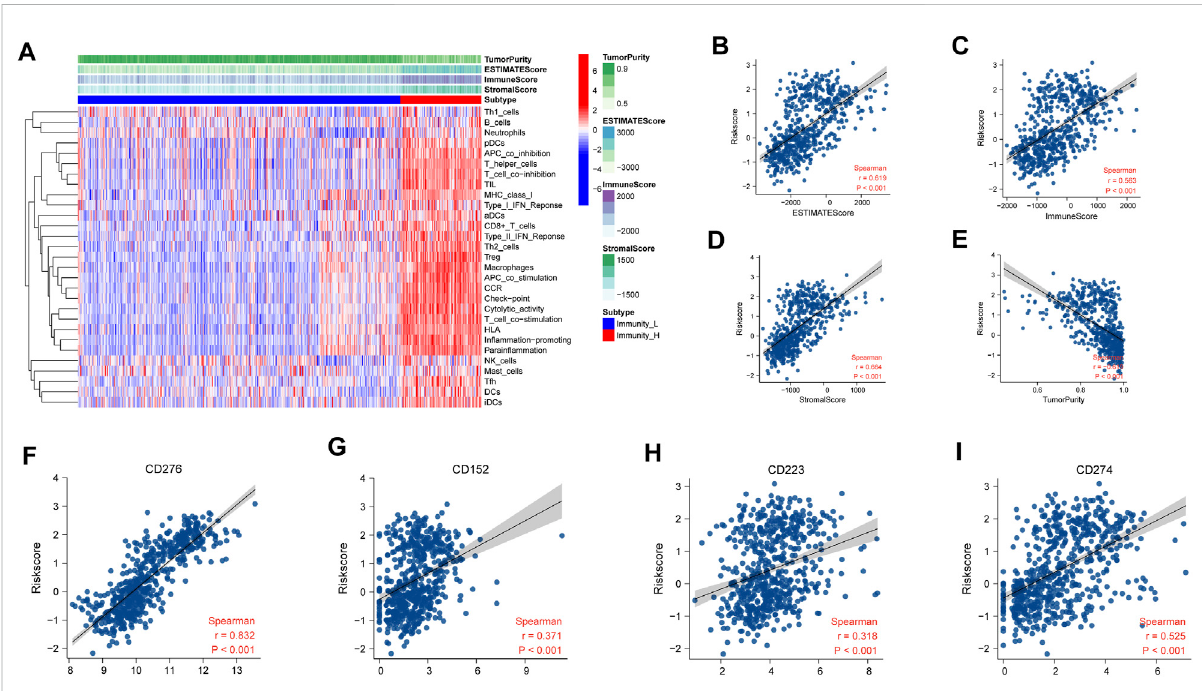
FIGURE 8 Assessment of immune in fi ltration in TCGA. (A) Heatmap of ssGSEA scores of immune cells and functions. (B – E) Relationship of risk score betweenESTIMATEscore(r=0.619, p < 0.001),immunescore(r=0.563, p < 0.001),stromalscore(r=0.664, p < 0.001),andtumorpurity(r=-0.679, p < 0.001). (F – I) Relationshipofriskscorebetweenimmunecheckpoints.CD276(r=0.832, p < 0.001),CD152(r=0.371, p < 0.001),CD223(r=0.318, p < 0.001), and CD274 (r = 0.525, p < 0.001). The relative mRNA expression of necroptosis-related signature genes in U118, U138, LN229, and HS683 glioma cell lines compared to